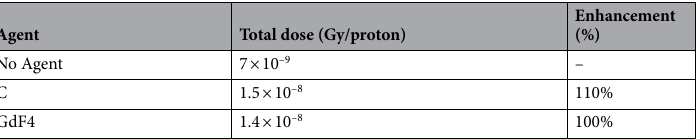
Table 3. The calculated total dose related to the α-particles without nano-target (no agent) and in presence of one nano-target of C and GdF4. As it is shown, the dose has been enhanced almost 100% when one nano- target is included.